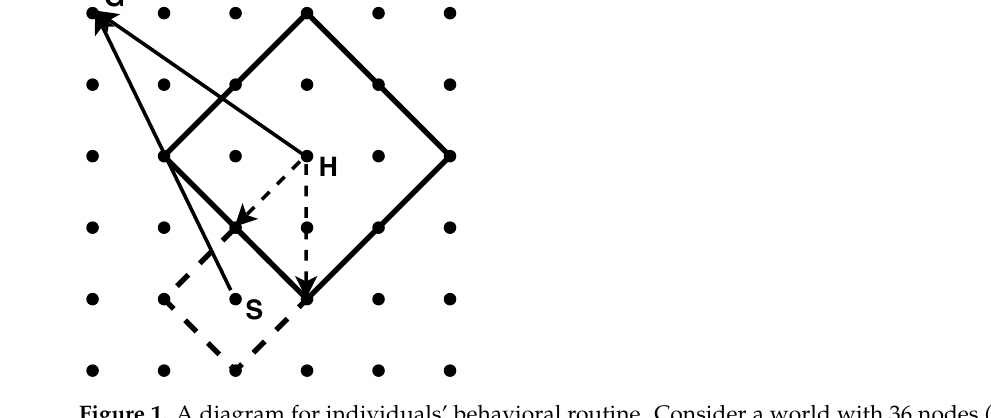
Figure 1. A diagram for individuals’ behavioral routine. Consider a world with 36 nodes ( d 1 = 2, d 2 = 1), among which there are only one infected node (S), one health node (H) and one gathering spot